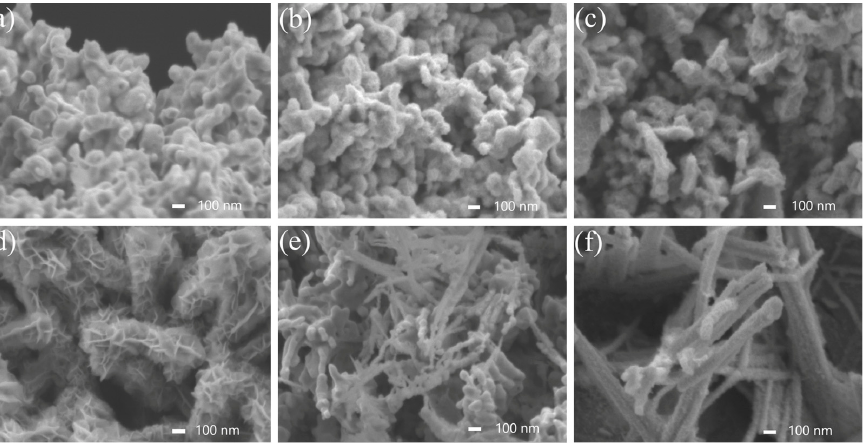
Figure 3. SEM images of ( a ) Ni 3 N; ( b ) Ni 0.9 Co 0.1 N; ( c ) Ni 0.5 Co 0.5 N; ( d ) Ni 0.3 Co 0.7 N; ( e ) Ni 0.1 Co 0.9 N; ( f ) Co 2 N 0.67 . Catalysts 2023 , 13 , x FOR PEER REVIEW